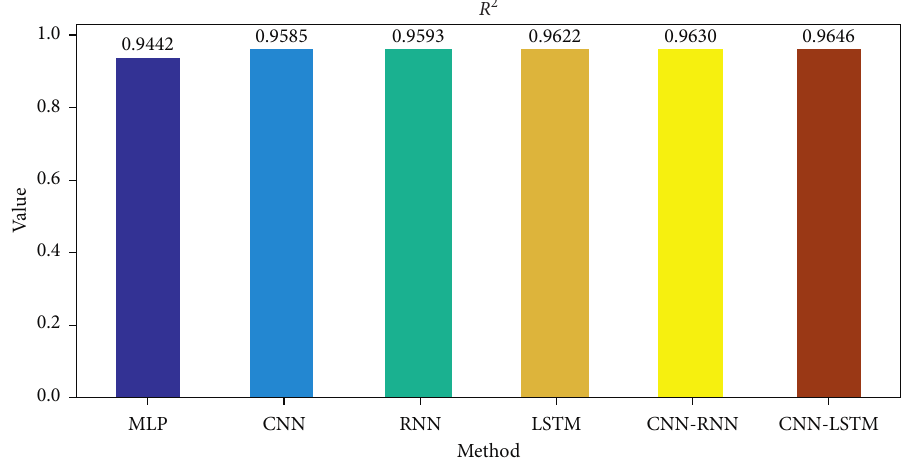
Figure 13: The result of R 2 comparison among different